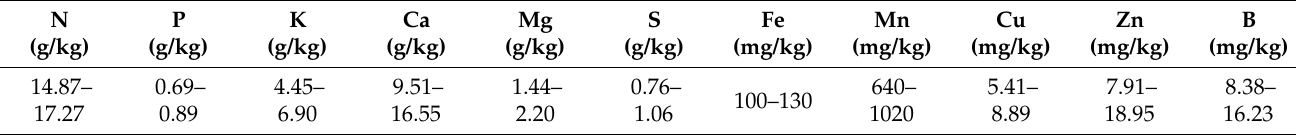
Table 1. Diagnostic criteria of elements in mango leaves